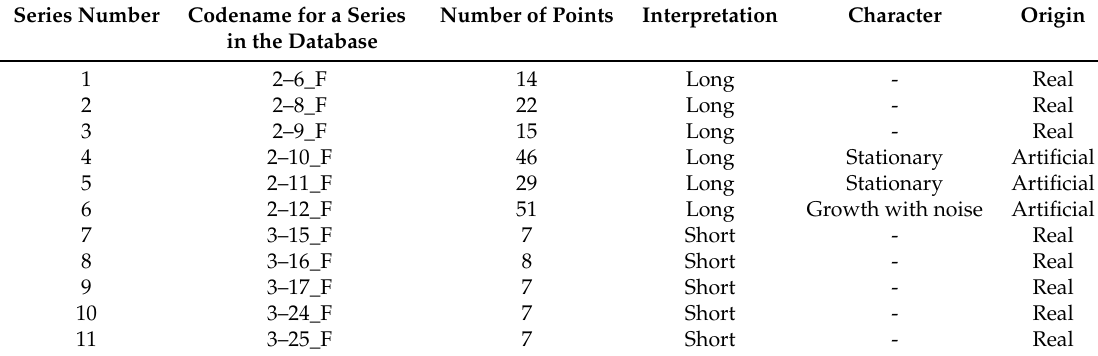
Table 5. Description of the economic series.